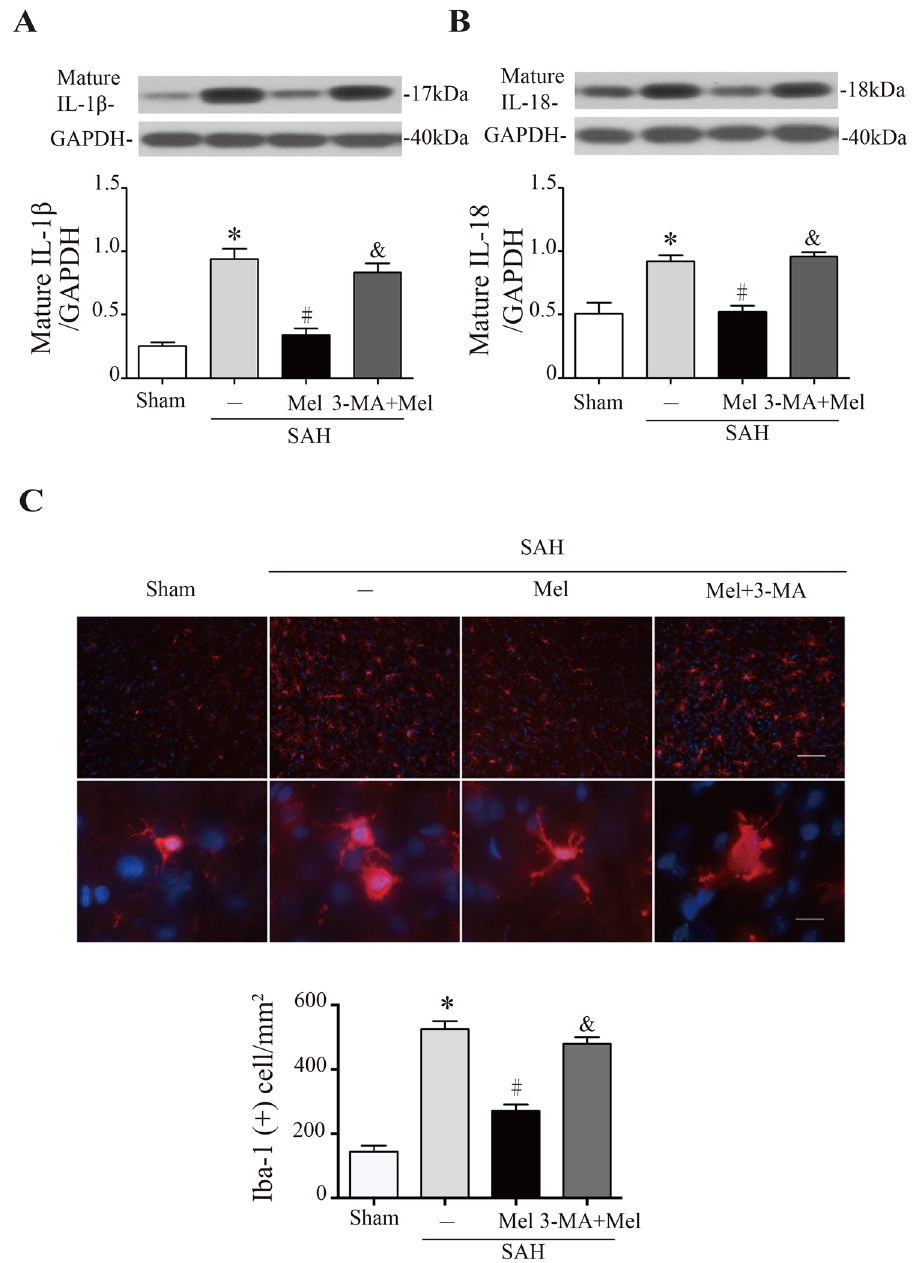
Figure 5. Melatonin treatment inhibits microglia activation and pro-inflammatory cytokine secretion. ( A ) The Western blot relative band density of IL-1 β ; n = 6 per group. ( B ) The Western blot relative band density of IL-18; n = 6 per group. The cropped bands had been run under the same experimental conditions. ( C ) Upper: representative micrographs showing microglial activation in the lesion area at 24 h after SAH, with immunofluorescence for Iba-1. Upper scale bar = 50 μ m, lower scale bar = 10 μ m. Lower: quantification of Iba-1-positive cells. * P < 0.05 versus sham group, # P < 0.05 versus SAH + vehicle group, and & P < 0.05 versus SAH + Mel